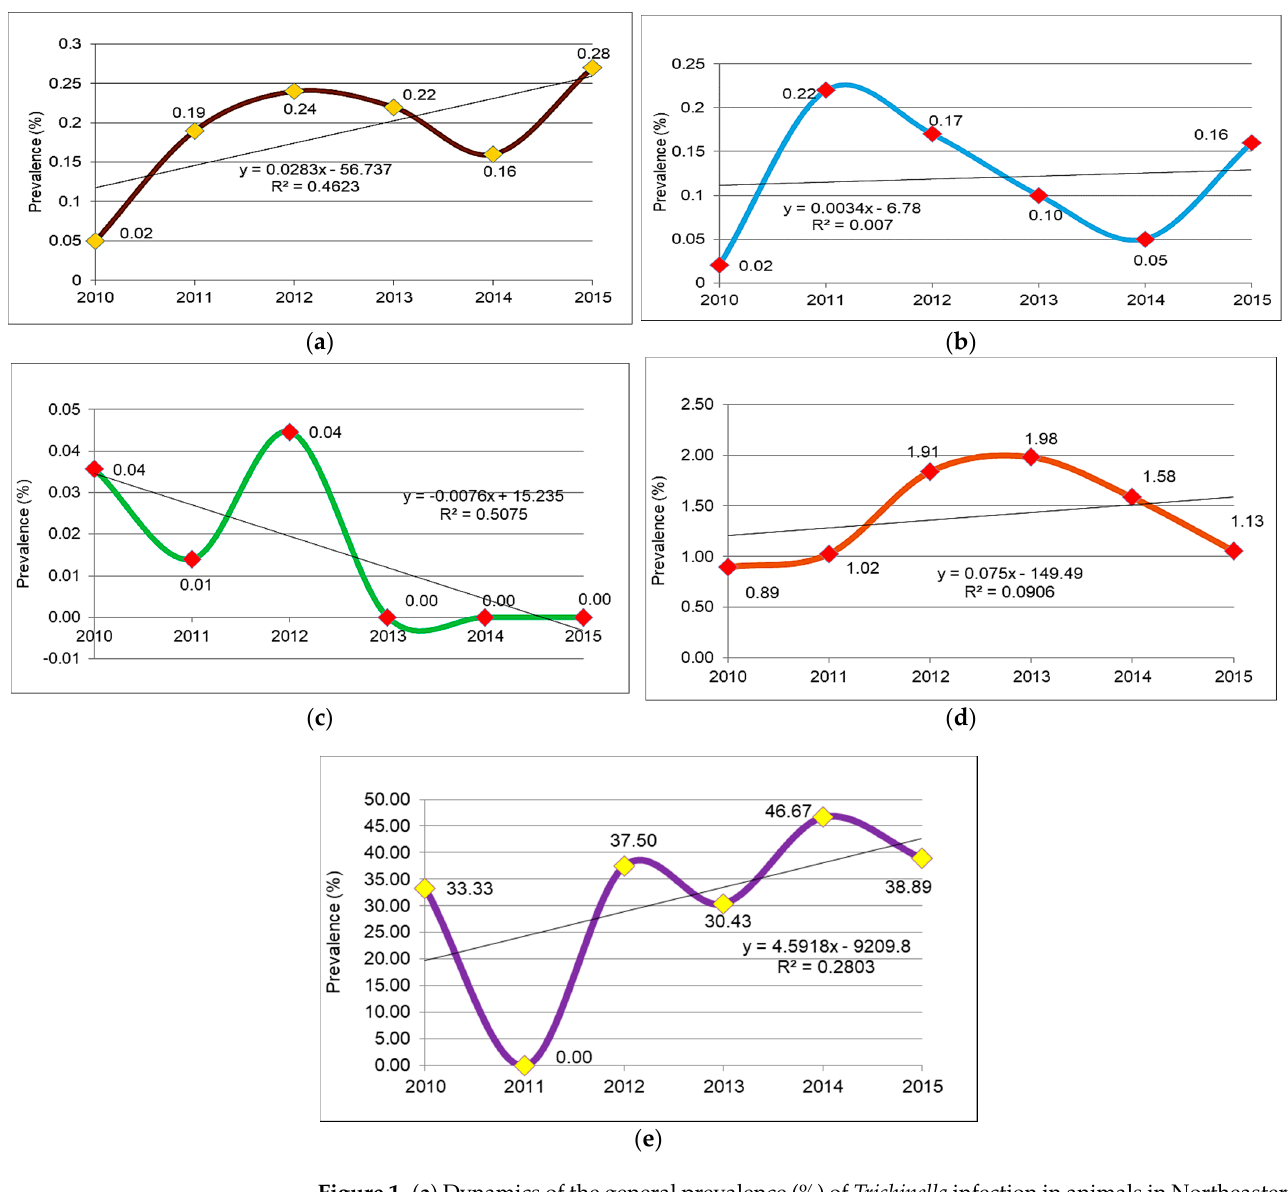
correlation coefficient (R 2 ) and the trendline are presented in Figure 1a.